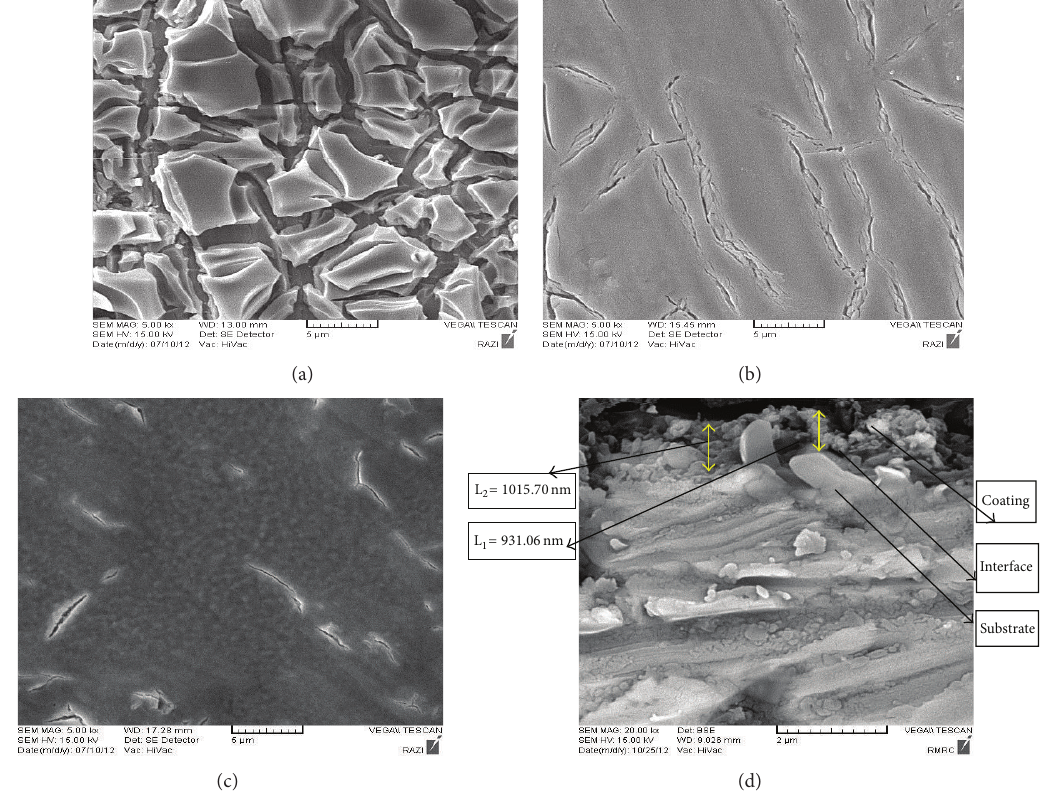
Figure 3: (a)–(c) SEM images of the surface of coated samples with different sintering temperature (a) 200 ∘ C, (b) 400 ∘ C, (c) 700 ∘ C, and (d) SEM image of the cross section of coated sample (15 layers, 700 ∘ C).